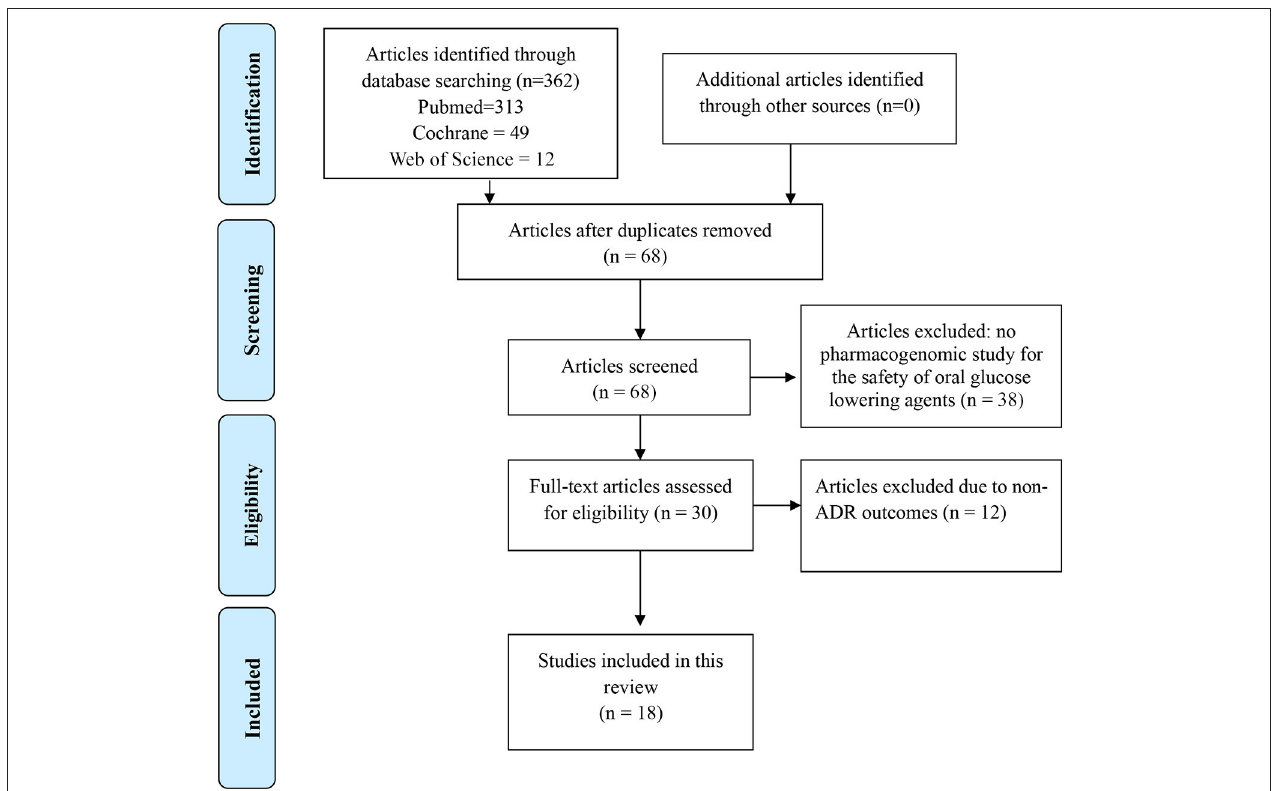
FIGURE 1 | PRISMA flow diagram for search results October 30,